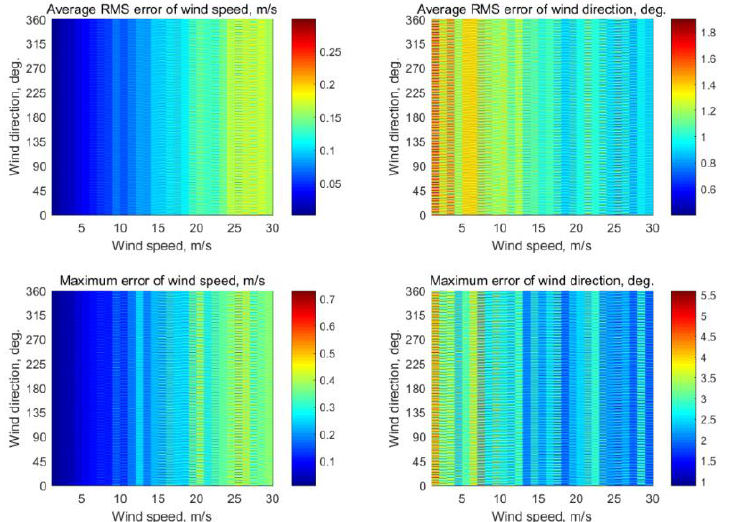
Figure A14. Simulation results of the use of three incidence angles of 30 ◦ , 35 ◦ , and 40 ◦ for wind retrieval.